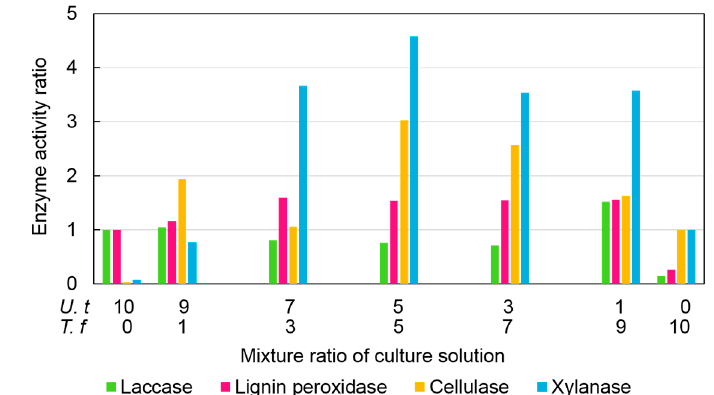
Figure 3. Influence of the mixture ratio of T. fusca and U. thermosphaericus inoculums on each enzyme activity after 7 days of incubation. Laccase and lignin peroxidase activities are expressed in ratios based on the U. thermosphaericus monoculture. The cellulase and xylanase activities are expressed in ratios based on the T. fusca